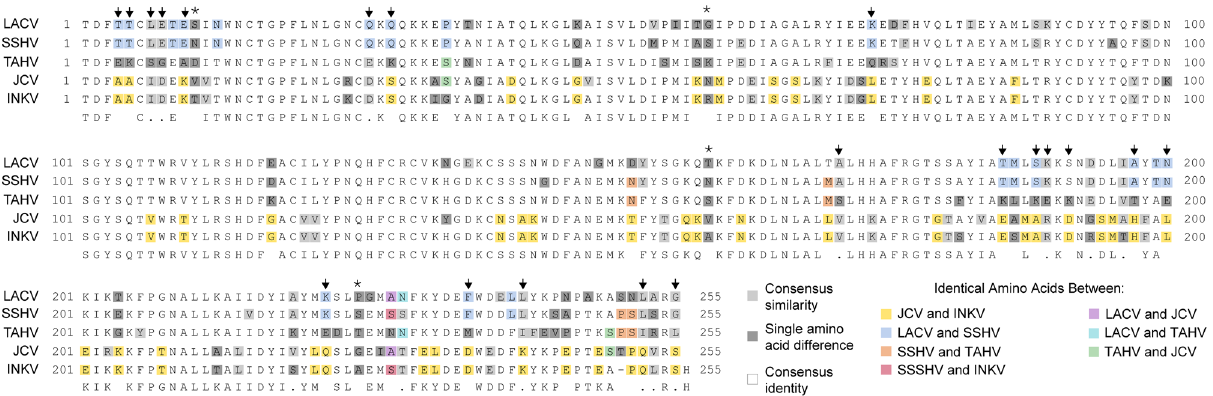
Figure 3. Gc Head Domain alignment. No shading indicates consensus amino acid identities across the five sequences, light gray shading indicates consensus similarities across the five sequences, dark gray shading indicates differences in individual virus amino acid, and color shading indicates shared amino acids between two viruses (see legend). Arrows point out sites where LACV & SSHV share, JCV & INKV share, and TAHV has a different amino acid. Asterisks show sites where all five viruses have a different amino acid. Sequence alignments were performed in MacVector version 17.5.4, and the figure constructed in Adobe